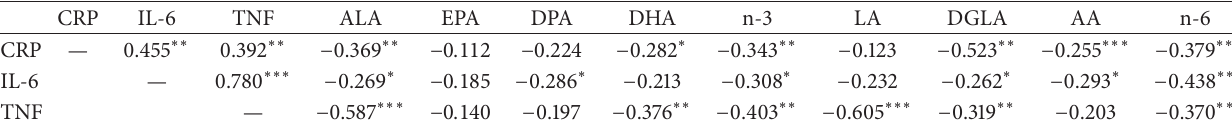
Table 4: Correlation matrix between inflammatory markers and serum phospholipids fatty acid percentage in dietary intervention